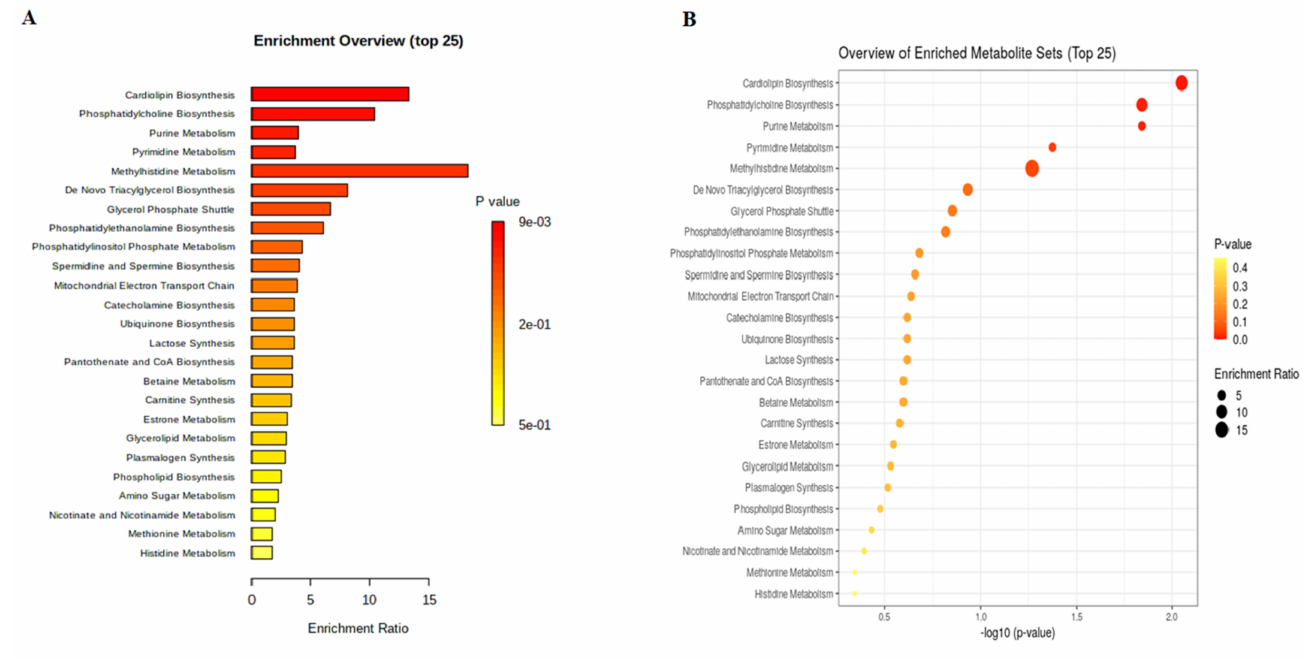
Figure 5. Extracted ion chromatograms of the significantly expressed metabolites. Extracted ion chromatograms from LC–MS/MS analysis of the plasma metabolites (blue line) and their deuter- ated internal standards (red line). The data were obtained from a pooled plasma sample. The chromatograms demonstrate clear retention time and peak area overlap with the deuterated inter- nal